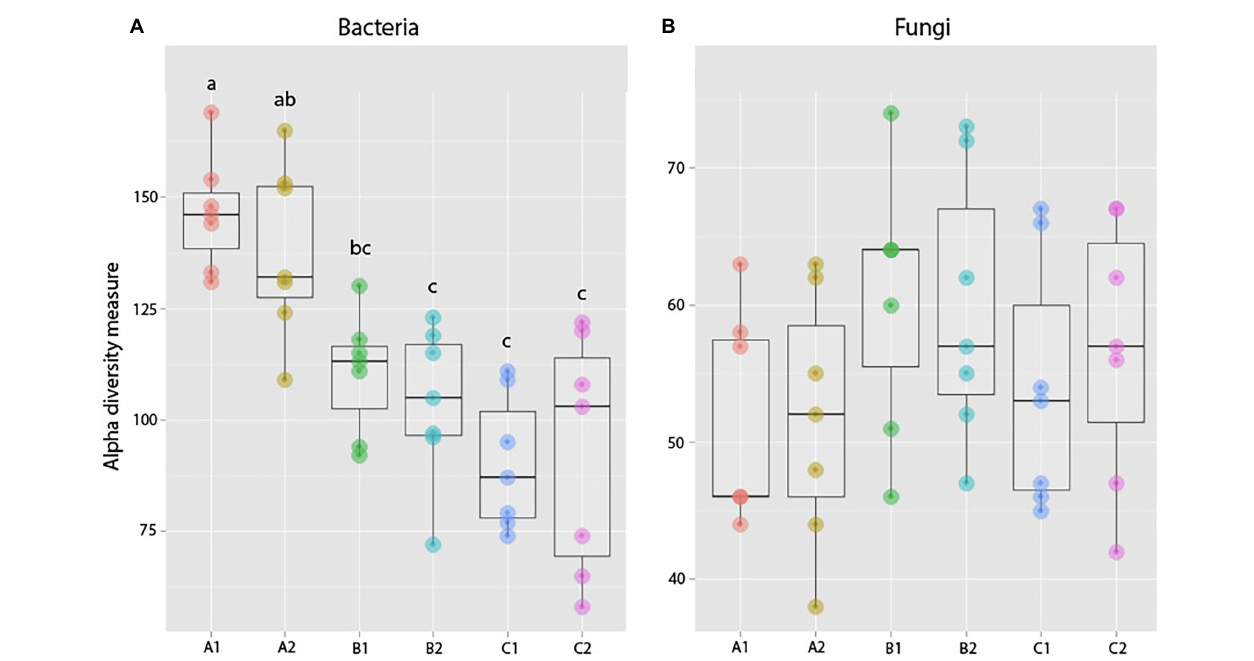
FIGURE 8 | Observed species richness of bacterial (A) and fungal (B) root communities among roots exposed to resident (1) or exogenous (2) soils at different ages (a, b, and c). There was an overall decrease in bacterial richness over the course of the experiment, but no significant difference in richness between plants of the same age but with different soil exposure. For fungal communities, results show no significant difference between plants with different soil exposures. These observations were in accordance with Duncan test results (significant differences indicated by different lowercase